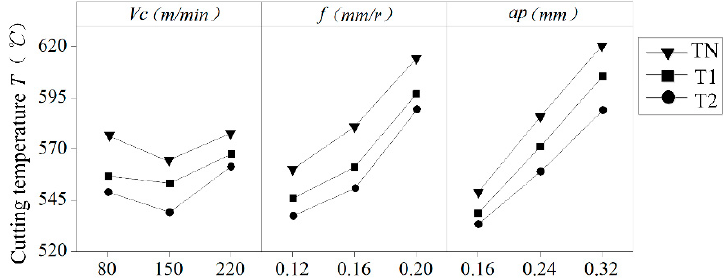
Figure 14. Single factor effect of cutting parameters on cutting temperature.